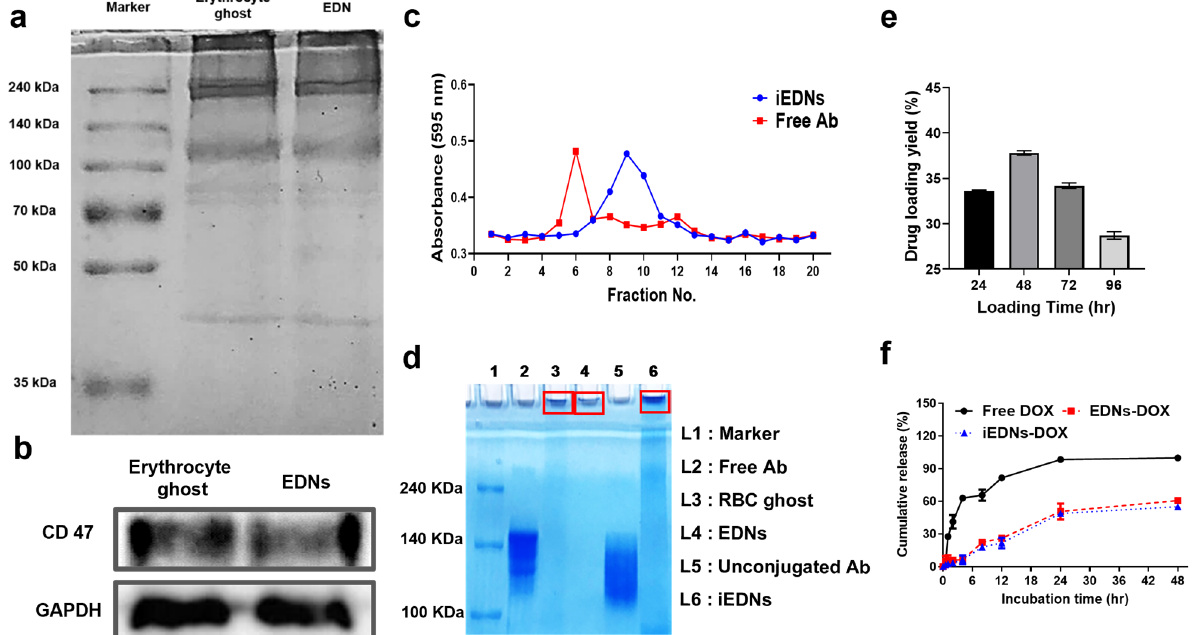
Figure 1. Preparation and characterization of immuno-erythrocyte-derived nanoparticles (EDNs) (iEDNs)-doxorubicin (DOX). ( a ) Membrane proteins in erythrocyte ghosts and EDNs were separated by 8% sodium dodecyl sulfate-polyacrylamide gel electrophoresis (SDS-PAGE) and stained with Coomassie Brilliant Blue. ( b ) The expression of cluster of differentiation CD47 of Erythrocyte ghost and EDNs was verified by Western blotting. The expression of GAPDH is used for control. ( c ) After cetuximab conjugation to the EDN surface, iEDNs were separated by gel filtration and ( d ) the separated iEDNs were subjected to 6% non ‐ reducing PAGE. ( e ) For DOX encapsulation, the drug was added to the iEDNs that had 300 mM ammonium phosphate inside and 25 mM 4 ‐ (2 ‐ hydroxyethyl) ‐ 1 ‐ piperazineëthanesulfonic acid (HEPES) outside, and incubated. Time ‐ dependent DOX encapsulation into the iEDNs was analyzed by measuring the absorbance at 480 nm. ( f ) While dialyzing EDNs ‐ DOX, the released DOX was quantified at various time points. Each error bar represents the mean ± standard deviation (S.D.) for three separate experiments.